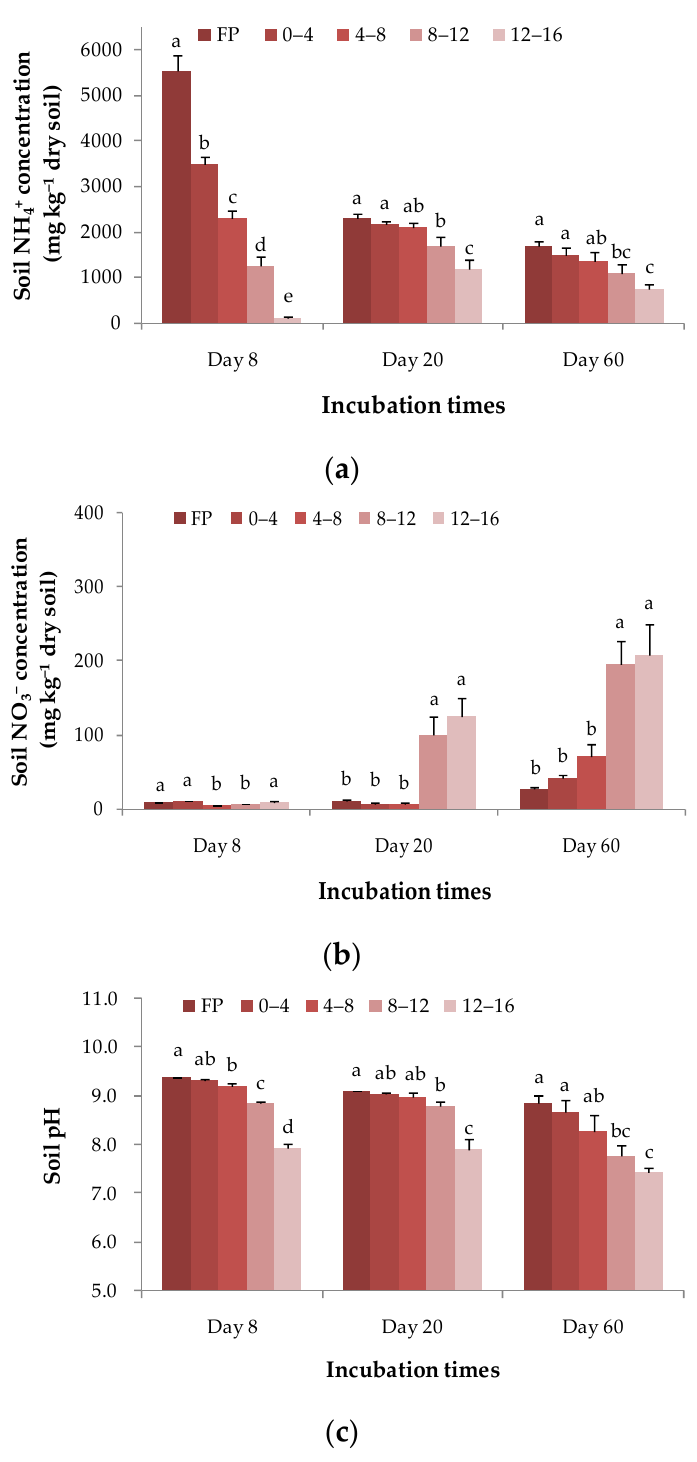
Figure 3. The soil mineral nitrogen concentration and pH value in different treatments and